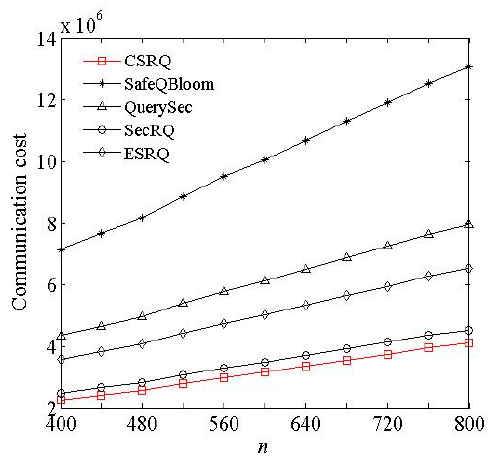
Figure 3. Impact of n on communication cost.